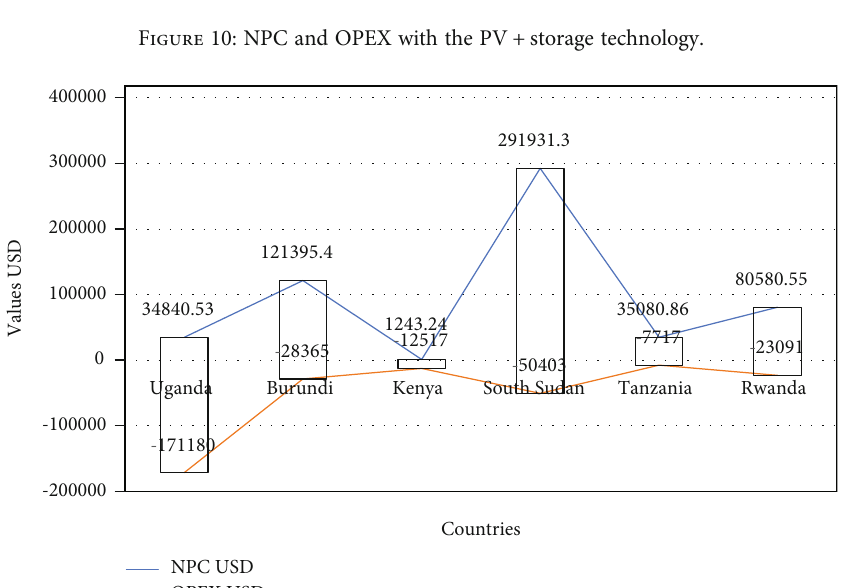
Figure 11: NPC and OPEX with the PV + storage + grid technology.